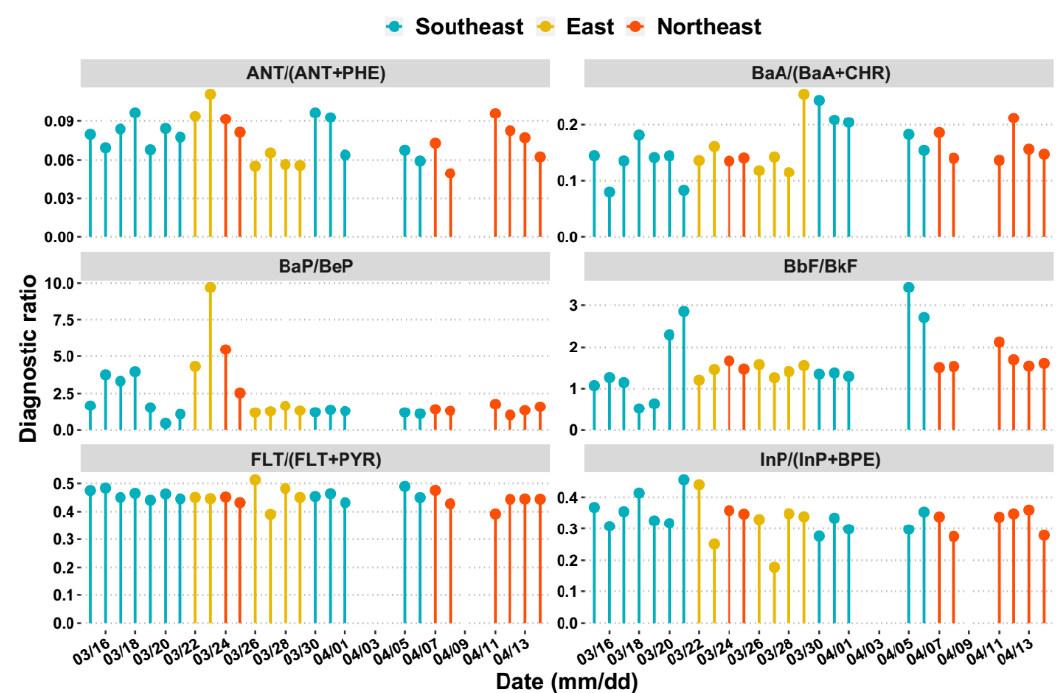
Figure 6. Time series of diagnostic ratio values during sampling period.